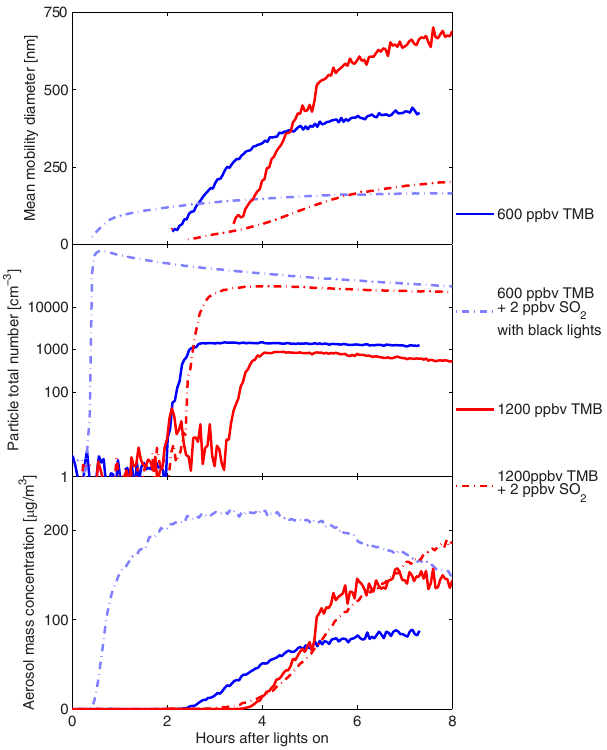
Figure 5. Mean diameter, total number concentration and aerosol mass concentration (assuming ρ p =1.4gcm − 3 ) from the scanning mobility particle sizer (SMPS) measurements. These data are not corrected for wall losses. High concentration experiments: red; low concentration experiments: blue; without SO 2 : solid lines; with SO 2 : dashed